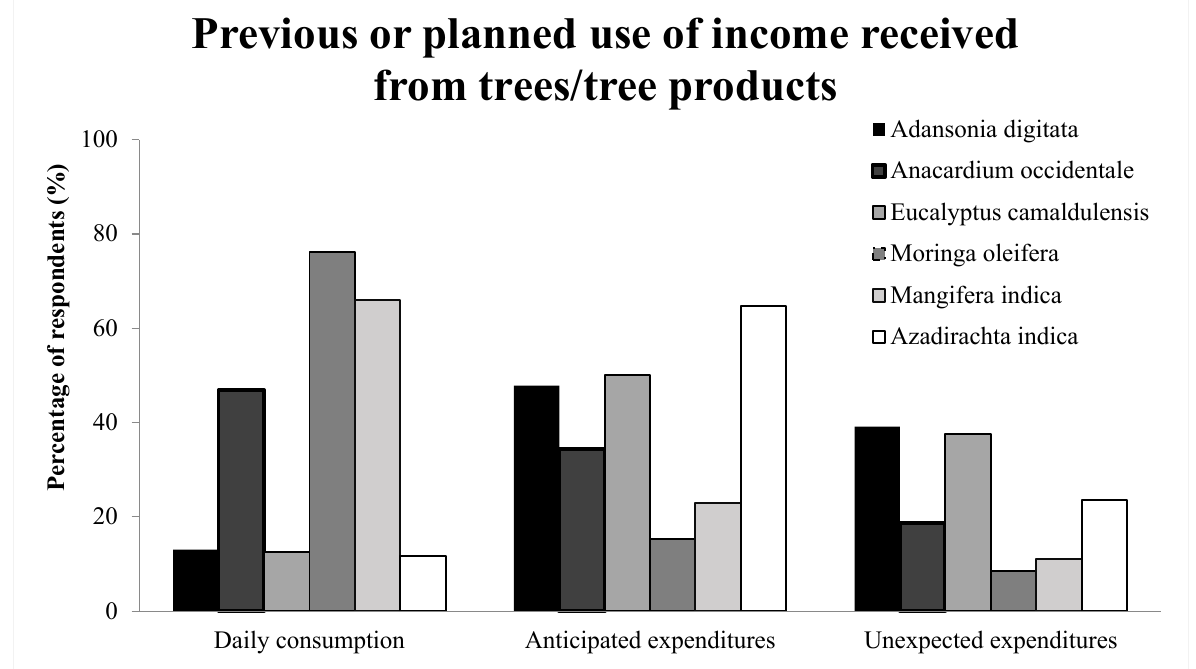
Figure 4. Previous or planned use of income received from trees/tree